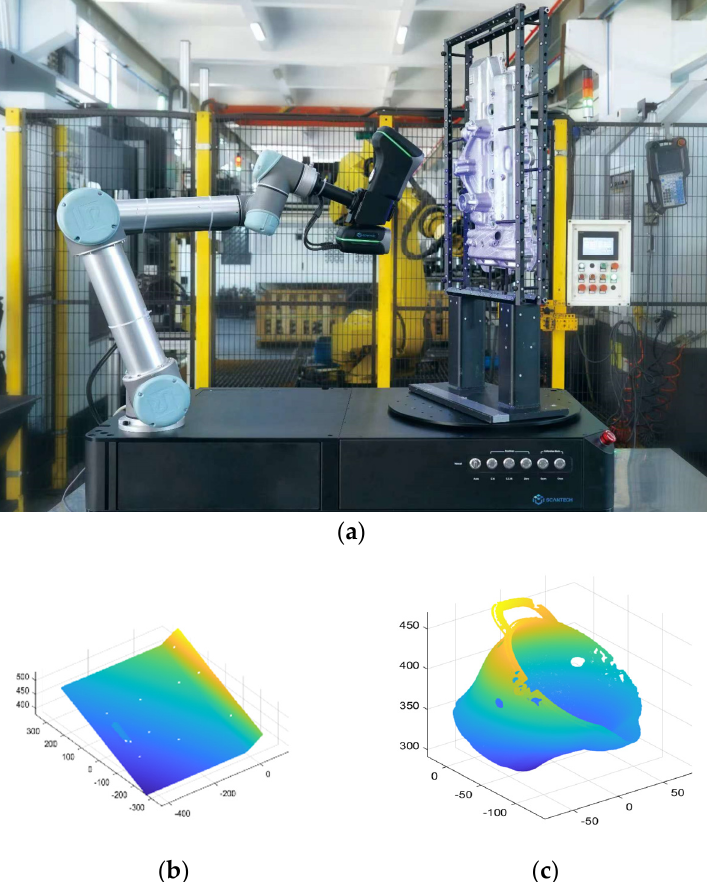
Figure 7. Collected surface workpiece point clouds. ( a ) Experimental platform; ( b ) Point cloud data of workpiece A; ( c ) Point cloud data of workpiece B.